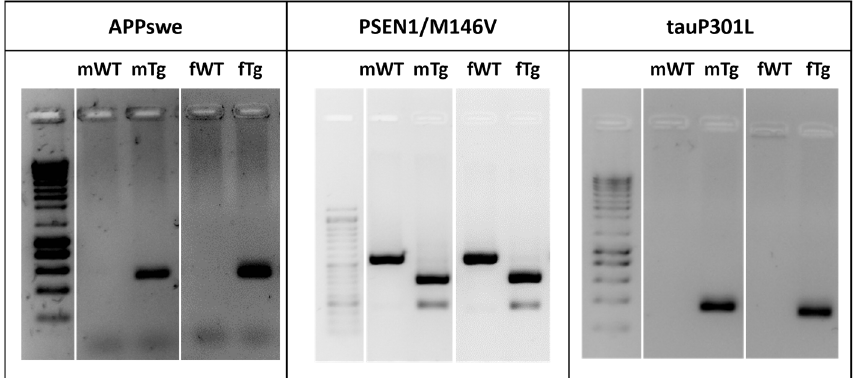
Figure 1. 3xTg-AD mice harbor APPswe , PSEN1M146V and tauP301L transgenes. Genotypic analysis for identification of 3xTg-AD mice. Representative gels comparing the human APPswe , PS1/M146V and tauP301L transgenes from tail DNA of breeding pairs (m—male and f—female) of WT and 3xTg-AD mice.